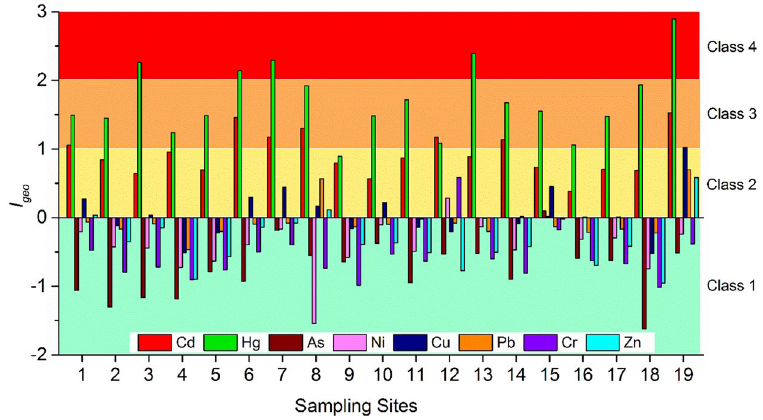
Figure 4. I geo values for heavy metals at different sampling